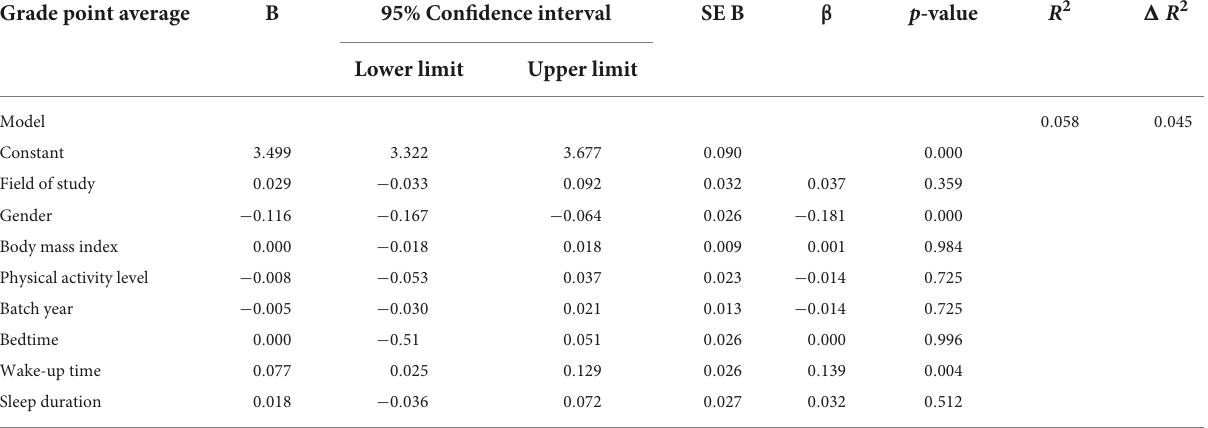
TABLE 2 Multiple regression results for grade point